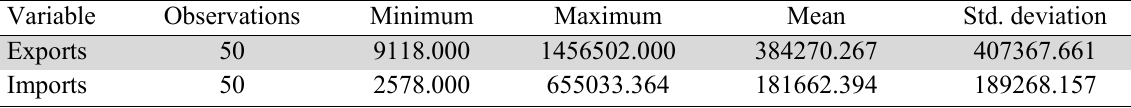
Summary Statistics of Export and Imports of the